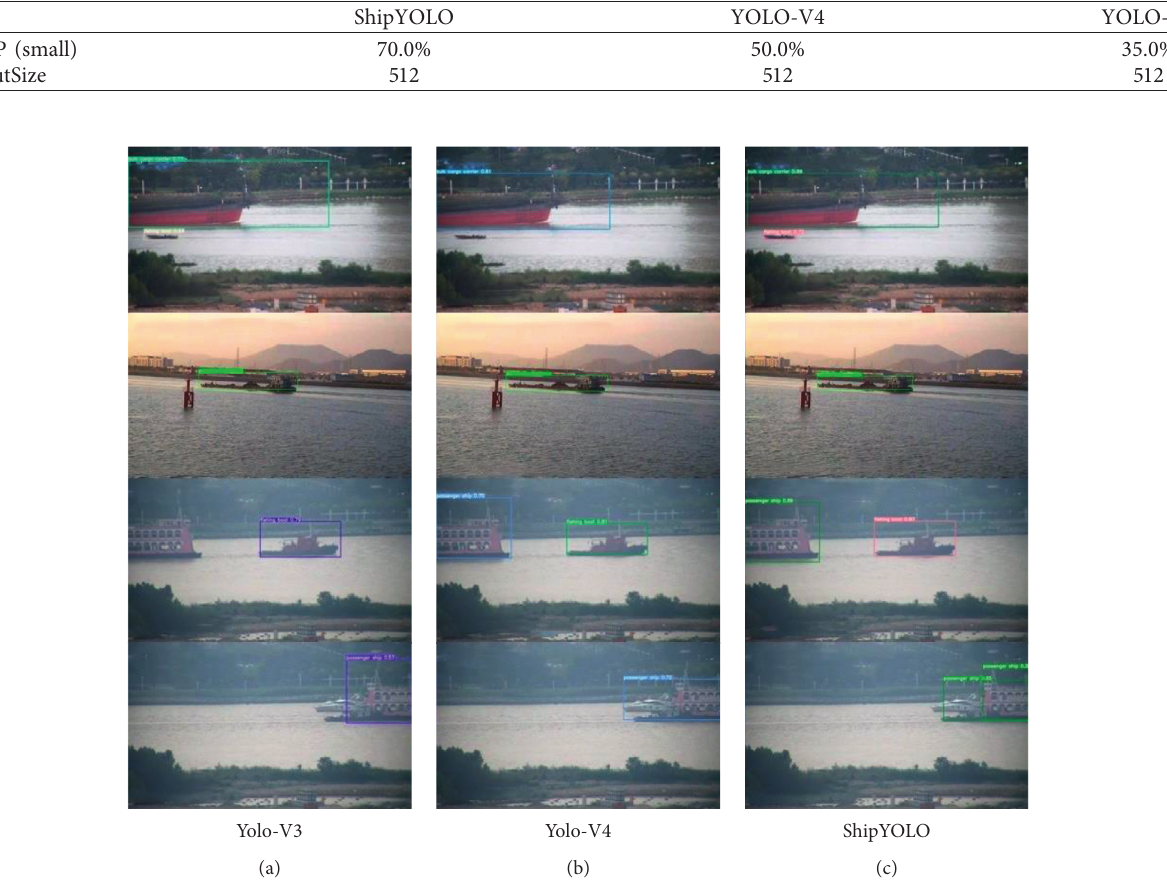
Table 4: Experimental results of the mAP (small).